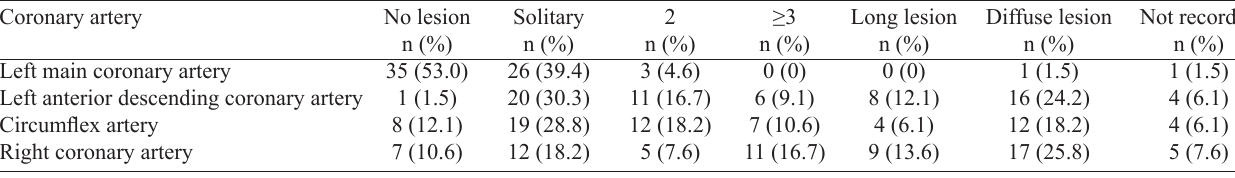
Table 2. Number or extent of the coronary lesions. Coronary artery Left main coronary artery Left anterior descending coronary artery Circumflex artery Right coronary